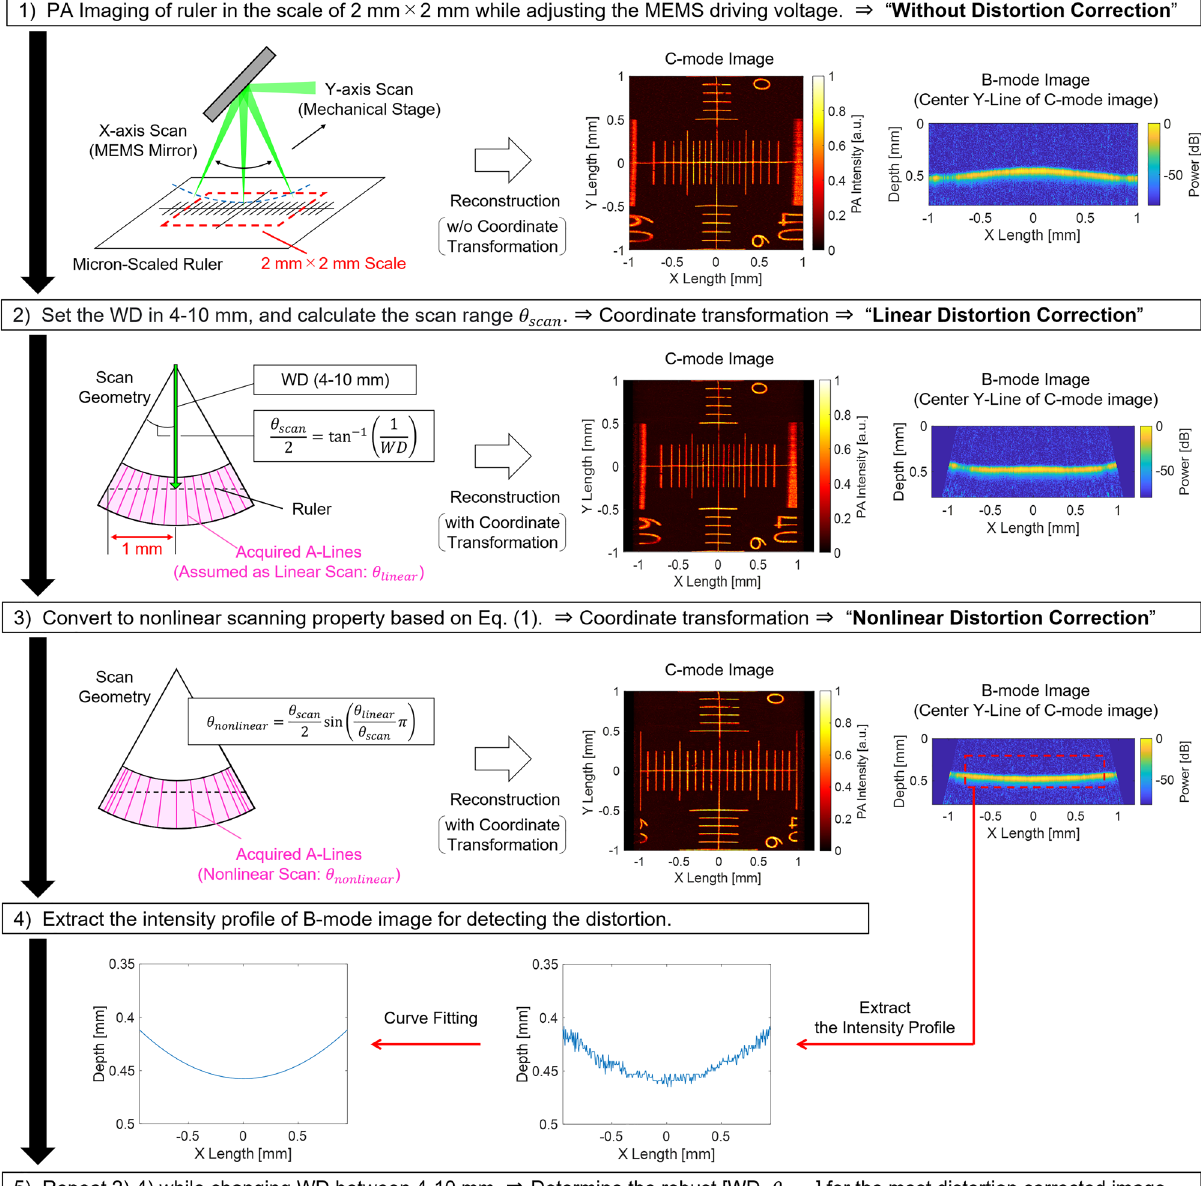
Figure 3. Proposed calibration method for the distortion correction using a